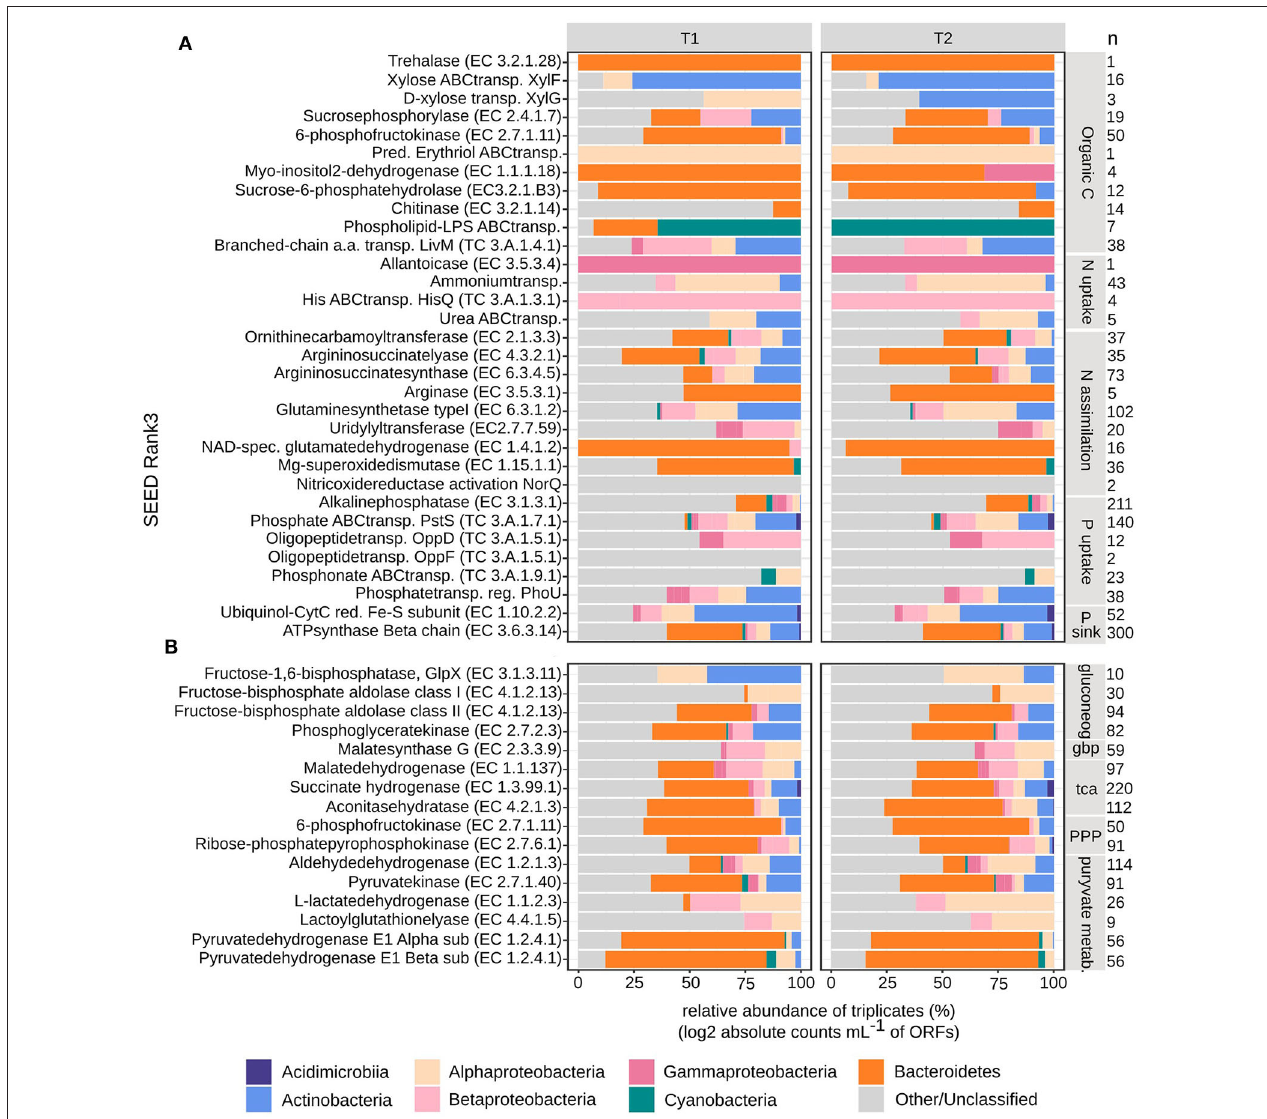
FIGURE 7 | Taxonomical distribution of bacterial metatranscriptome ORFs grouped into SEED Rank3. Absolute counts mL − 1 were log2 transformed and then relative abundances were calculated per timepoint (T1 and T2, in triplicates). Taxonomical groups are given at phylum or class level. (A) Carbon, nitrogen and phosphorous uptake and assimilation, (B) carbon cycling, n, signify the number of ORFs per Rank3